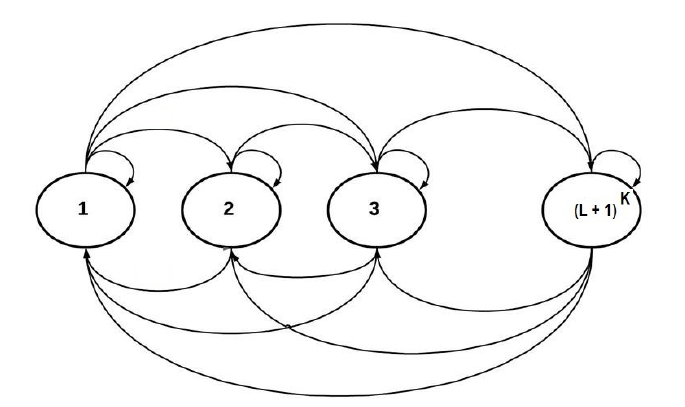
Figure 10. State transition flow diagram, showing one or more arrival and